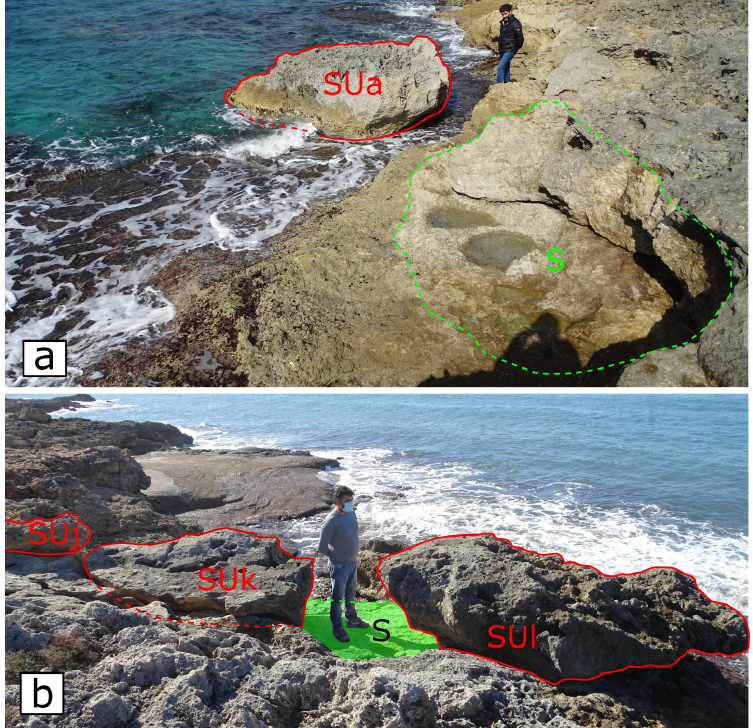
Figure 8. Torre Suda coastal stretch: ( a ) the largest boulder SUa and its socket taken from S. ( b ) The boulders SUj,k,l taken from N; the portion of SUl’s socket exposed by the displacement is highlighted in